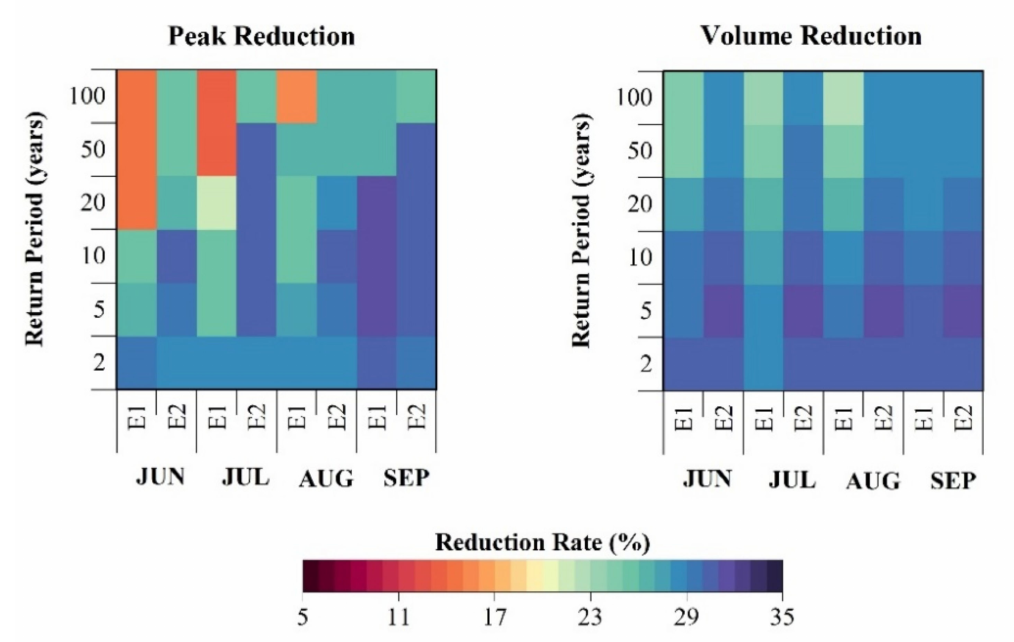
Figure 9. Extreme and average flood control